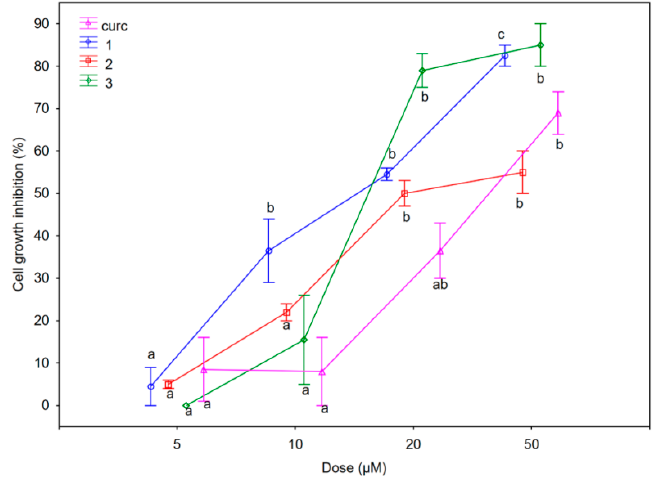
Figure 3. Cytotoxic activity of curcumin and its derivatives 1 – 3 on MDA-MB-231 cells. Cell viability was assessed by MTS assay. Data are expressed as mean of at least three different experiments performed in triplicate. Different letters represent significant differences in cytotoxic activity among the concentration (Tukey test, p < 0.05).